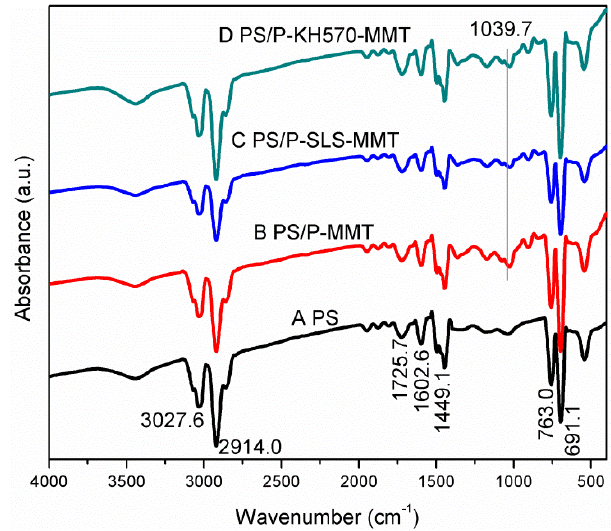
Figure 5. FTIR spectra of ( A ) PS, ( B ) PS/P-MMT, ( C ) PS/P-SLS-MMT, and ( D ) PS/P-KH570-MMT.